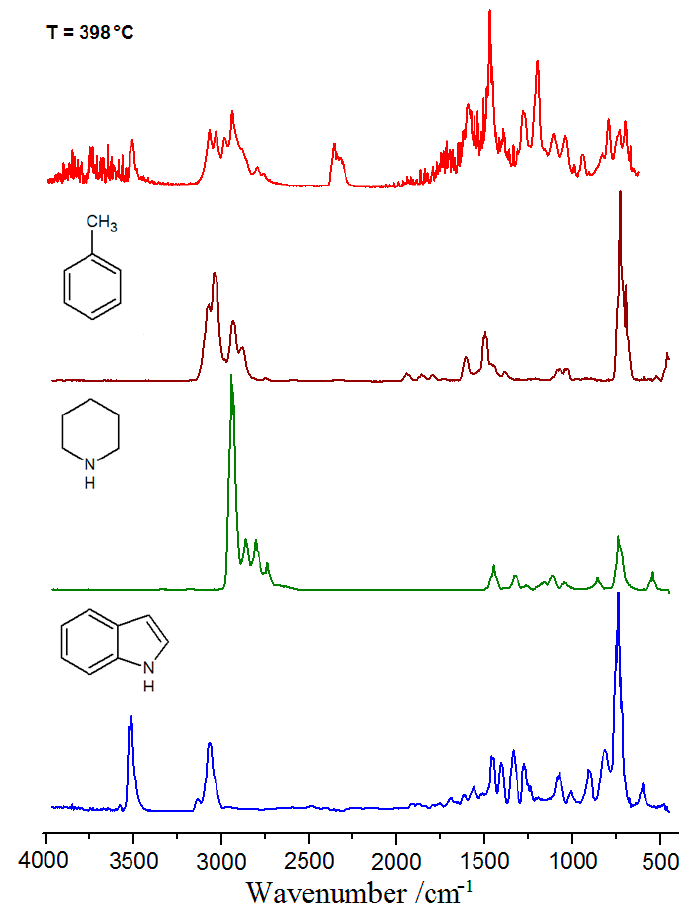
Figure 11. FTIR spectrum of volatile products of thermal decomposition of D2AAK1_3 recorded at 398 °C in inert atmosphere and the spectra of toluene, piperidine and indole.